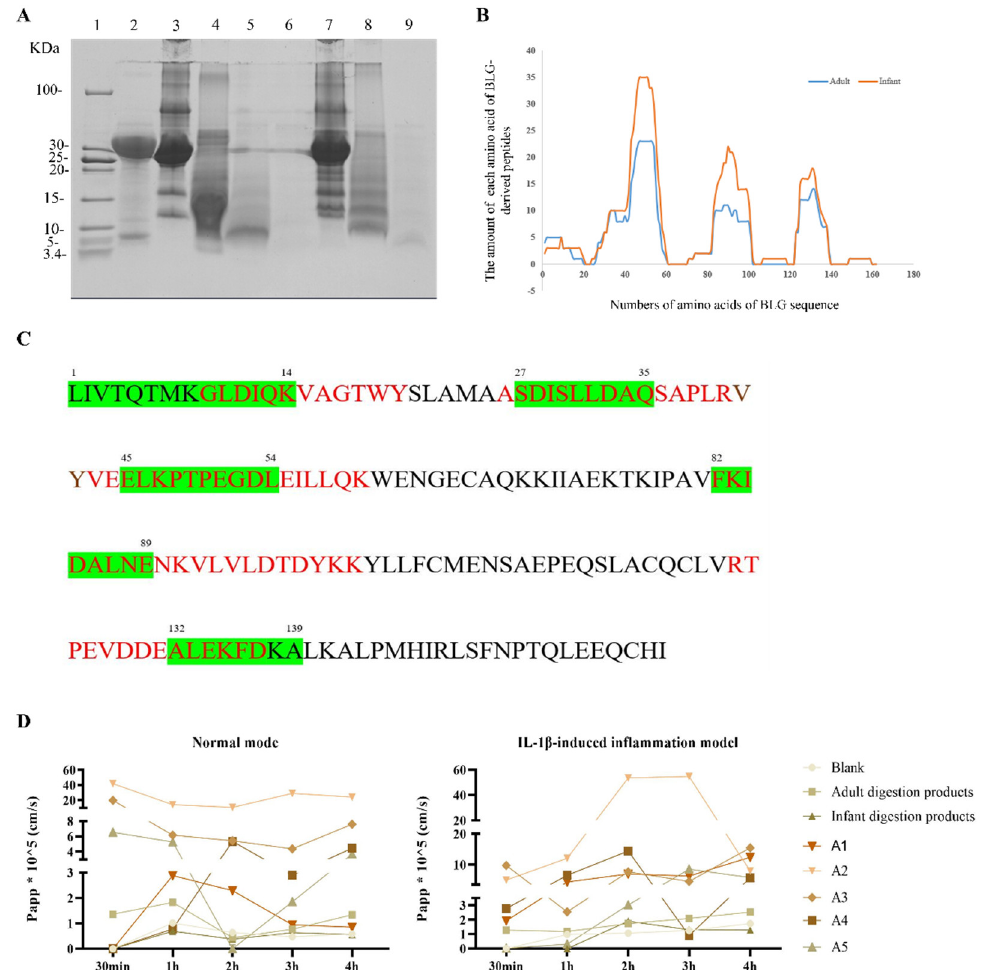
Figure 2. Gastric digestion of cow’s milk and the good transport ability of BLG digestion-derived peptides by the Caco-2 cell monolayer. The protein profile of cow’s milk after simulated digestion was detected by ( A ) Tricine-SDS-PAGE. Lane 1: unstained low range protein ladder. Lane 2: pepsin. Lane 3: the cow’s milk. Lane 4: cow’s milk digested in the simulated adult gastrointestinal fluid for 0 min. Lane 5: cow’s milk digested in the simulated adult gastric fluid for 60 min. Lane 6: cow’s milk digested in the simulated adult gastrointestinal fluid for 60 min. Lane 7: cow’s milk digested in the simulated infant gastrointestinal fluid for 0 min. Lane 8: cow’s milk digested in the simulated infant gastric fluid for 60 min. Lane 9: cow’s milk digested in the infant simulated gastrointestinal fluid for 60 min. ( B ) The line graph shows the distribution of BLG−derived peptide segments after simulated adult and infant digestion. Y−axis value represents the occurrence numbers of amino acids of BLG peptides. ( C ) The whole amino acid sequence of BLG used in our study; the red letters indicate the areas where unique peptides are present after the simulated digestion of the infants, while the green letters represent unique peptides in the adults’ digestion. ( D ) The Papp of BLG peptides across Caco−2 monolayers at 30 min, 1 h, 2 h, 3 h, and 4 h in the normal model and IL−1β−induced inflammation model, respectively. The data were calculated in three replicates. BLG, beta-lactoglobulin. Papp, apparent permeability coefficients.